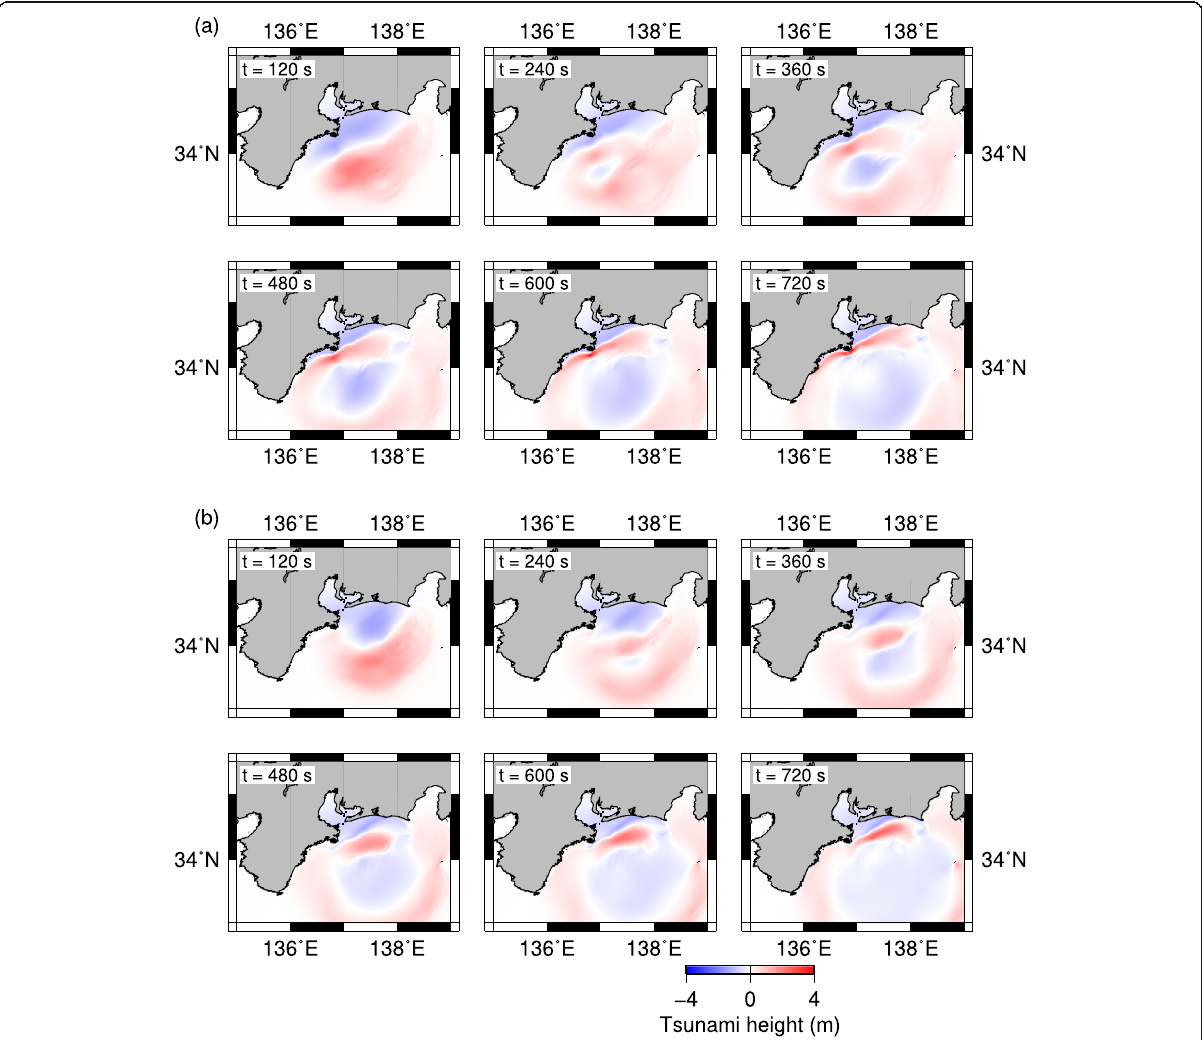
Fig. 9 Snapshots of tsunami propagation. For the scenarios that caused a the largest and b the smallest tsunami amplitudes in the area near the Shima Peninsula are shown. Time since earthquake initiation is indicated at the top left of each